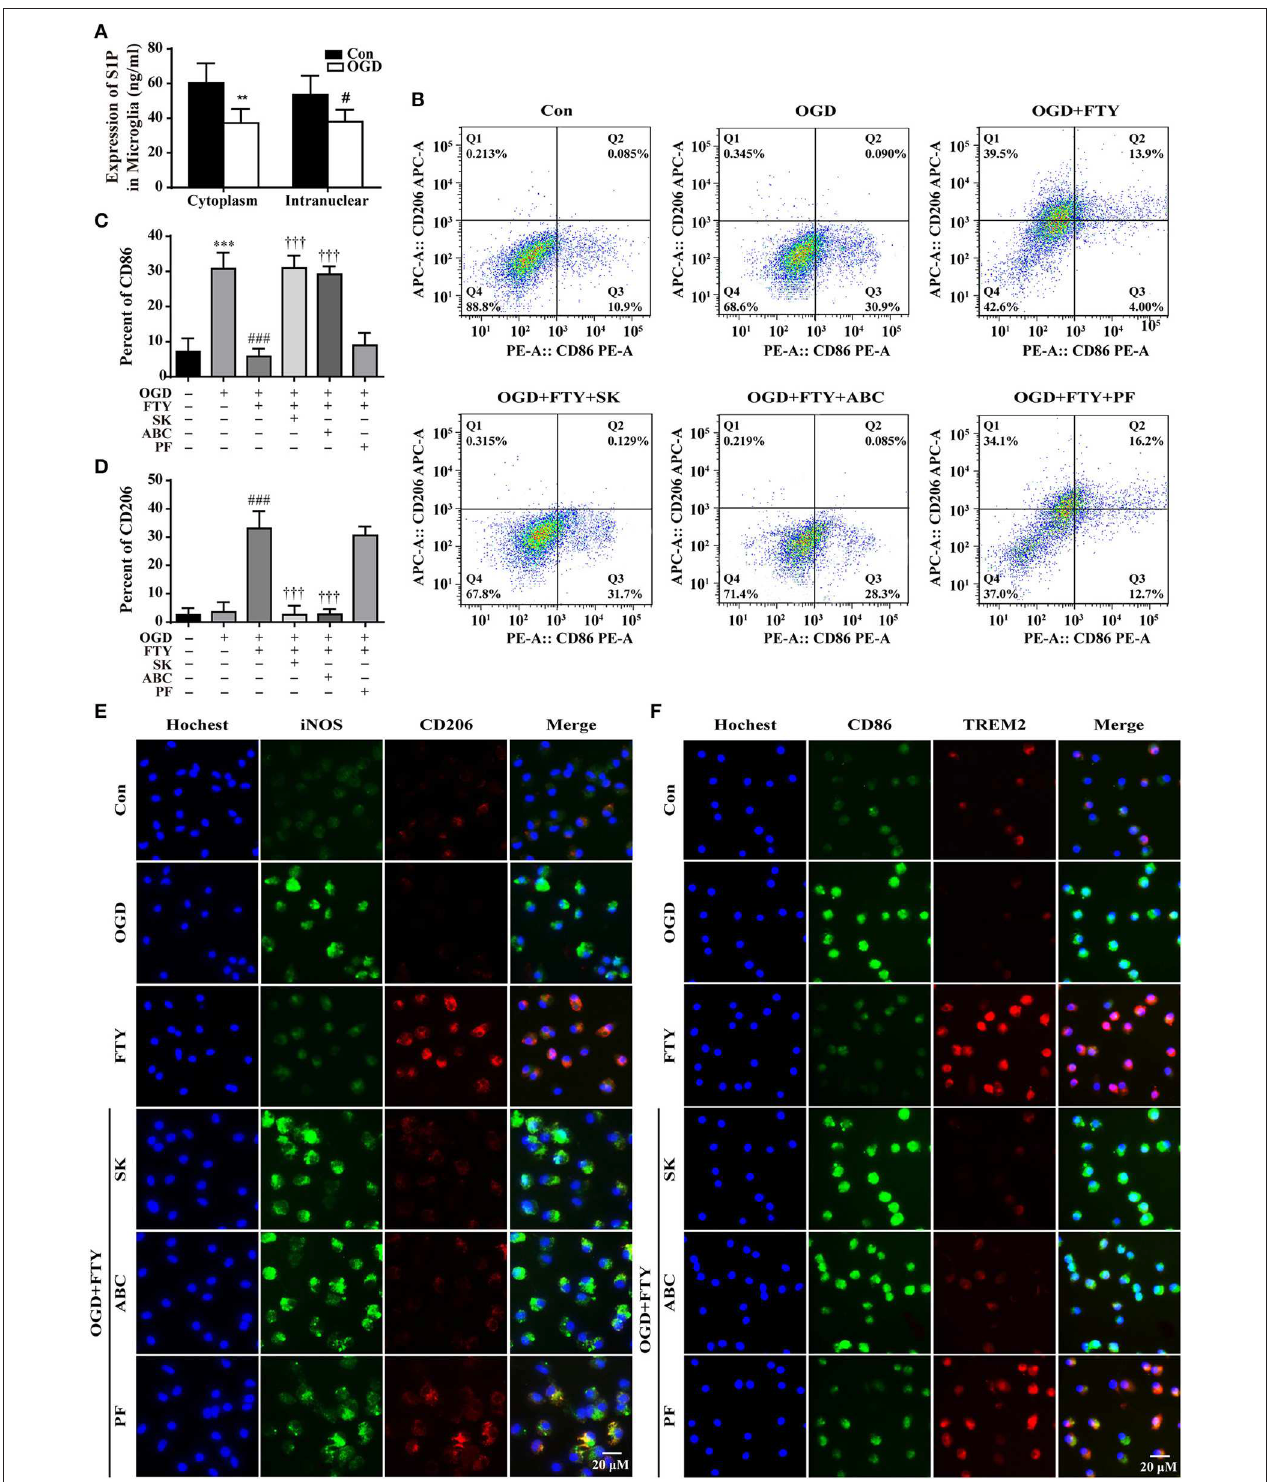
FIGURE 4 | Intra-nuclear SphK2-mediated phosphorylation is necessary for FTY720-facilitated the switch of microglial polarization from M1 to M2. (A) The expression of S1P was analyzed by ELISA. n ≥ 4 per group, ** p < 0.01, compared to the Con group in Cytoplasm; # p < 0.05, compared to the Con group in intra-nuclear, by Student’s t -test with unpaired. Fluorescence-activated cell sorting analysis of the microglia in the OGD, OGD + FTY720, OGD + FTY720 + SK, OGD + FTY720 + ABC,